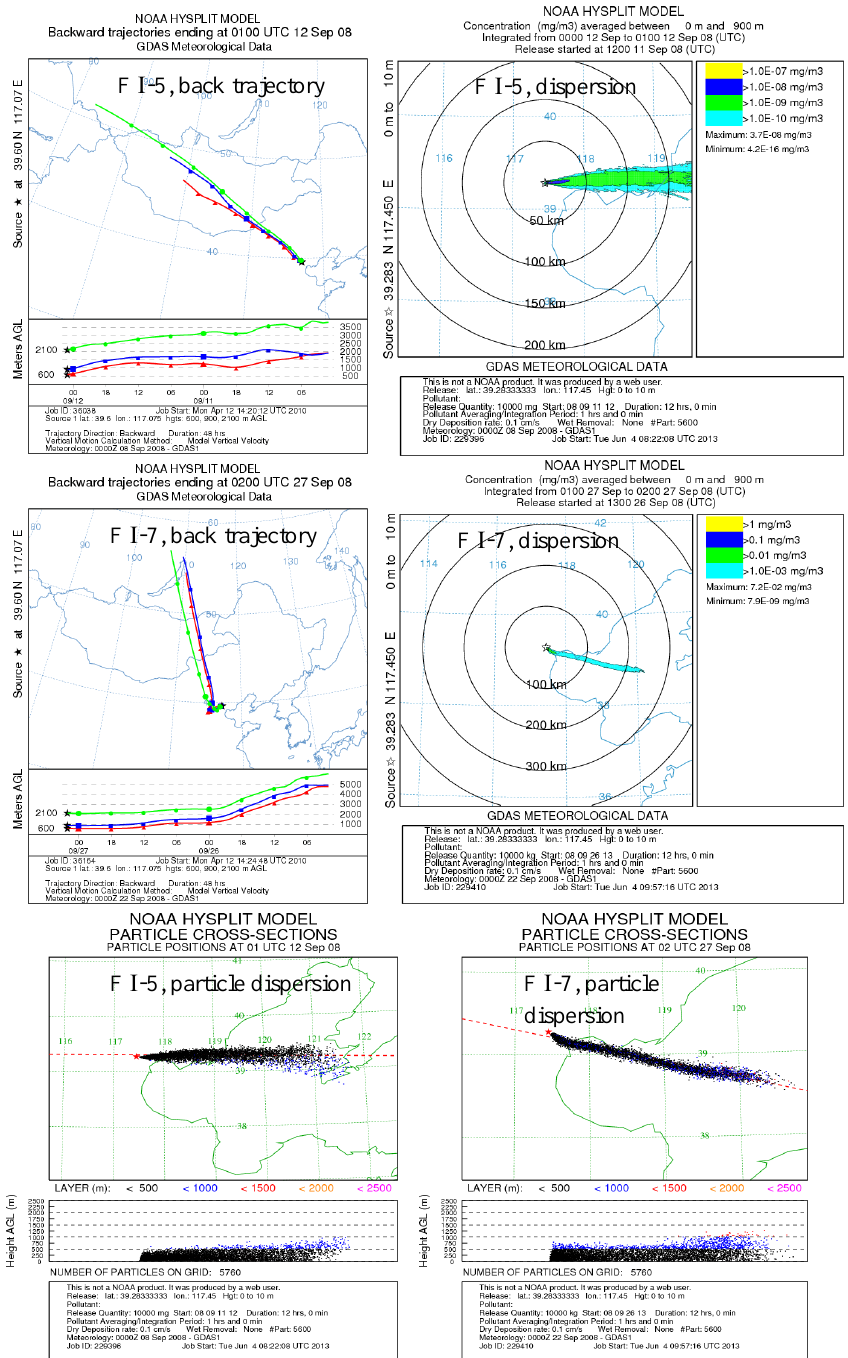
Fig. 5 A 48 h back trajectories and 12 h forecast dispersions for Flight Ι-5 and I-7 Fig. 5. 48h back trajectories and 12h forecast dispersions for flights I-5 and I-7 of G3. of G3. characteristics even within the same groups. Figure 7 gives an example of the variation of CO concentration from sev- eral flights at three